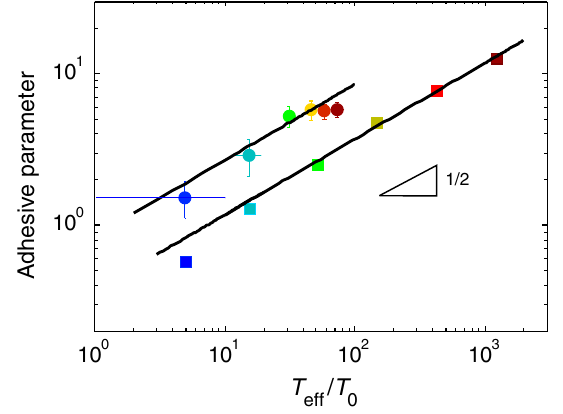
FIG. 4. Quantifying motility-induced adhesion. Evolution of adhesive parameter A obtained from the equation of state with the effective temperature obtained in the dilute limit for both experi- ments (circles) and simulations (squares). The lines correspond to ffiffiffiffiffiffiffiffiffiffiffiffiffiffiffi p T =T 0 the scaling law A ∼ , with slightly different prefactors eff for simulations and